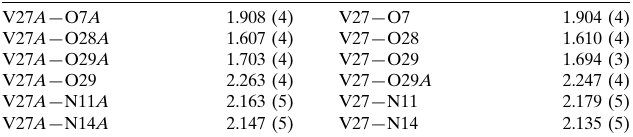
Selected bond lengths (A˚ ).